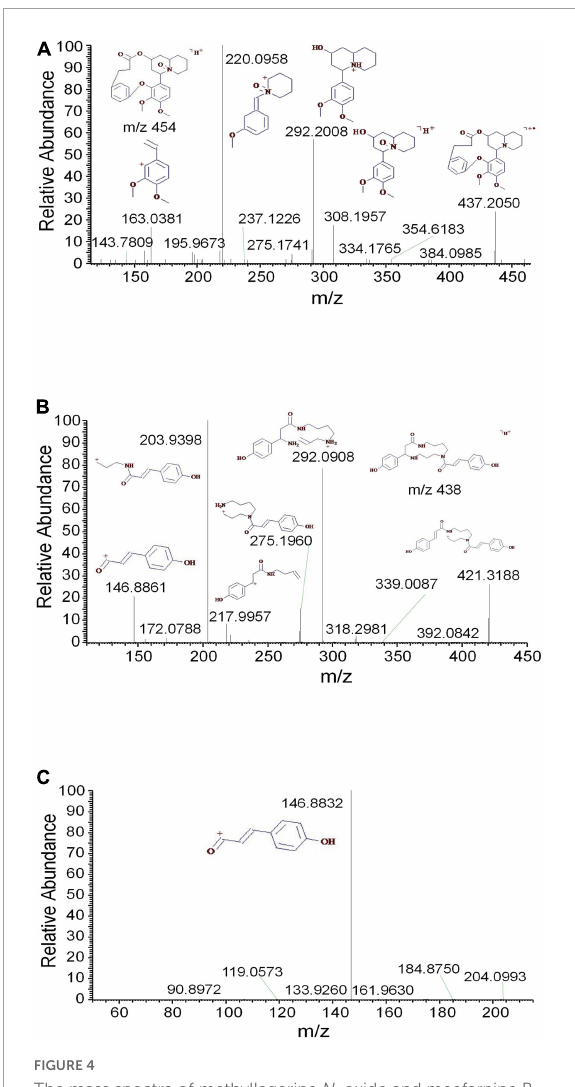
FIGURE4 The mass spectra of methyllagerine N -oxide and meefarnine B. (A) The MS 2 spectrum of methyllagerine N -oxide, (B) the MS 2 spectrum of meefarnine B, and (C) the MS 3 spectrum of meefarnine